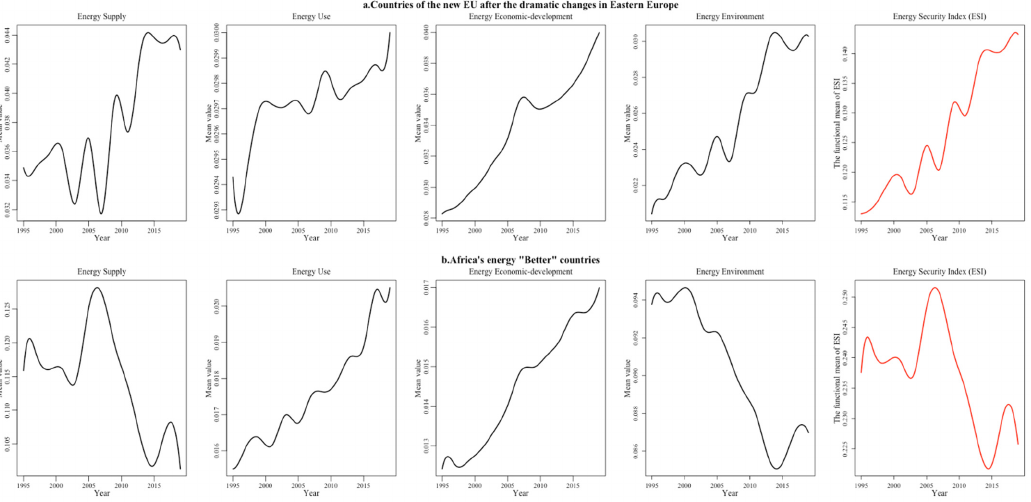
Figure 9. “Better” regional energy security system performance in four dimensions (part 1).